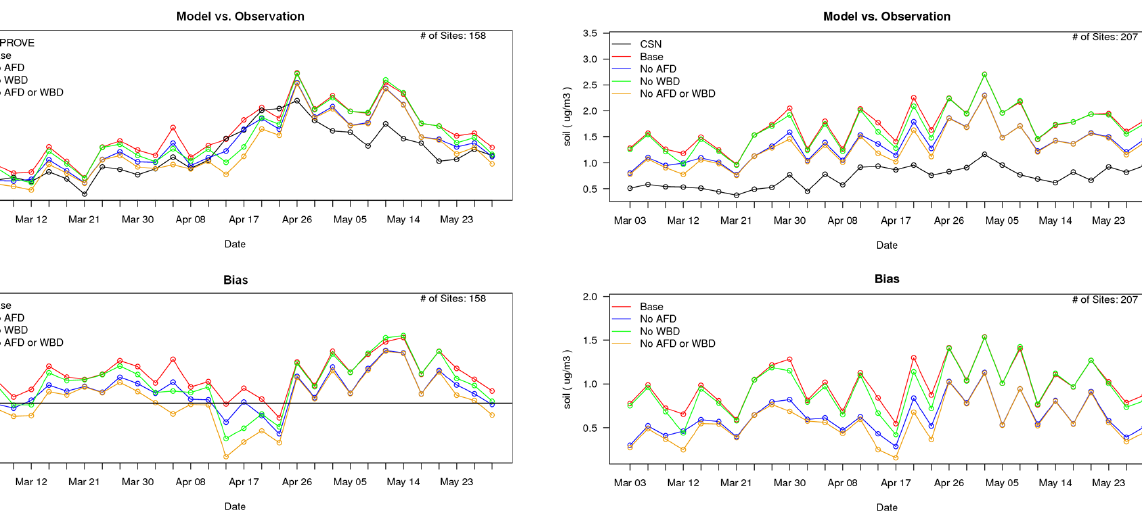
Fig. 9. Time series of CSN observed (black) and CMAQ simu- lated soil concentrations (µgm − 3 ; top) for the spring with the base CMAQ model simulation shown in red, the simulation with AFD emissions removed shown in blue, the simulation with WBD ef- fects removed shown in green, and the simulation with both AFD emissions and the effects of WBD removed shown in orange. The bottom time series shows the corresponding mean bias (µgm − 3 ) for the same model